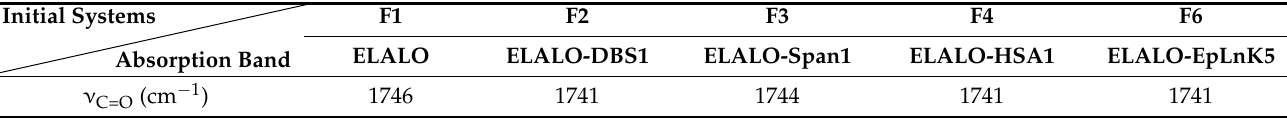
Table 2. Chemical shifts of C=O stretching band for ELALO-based formulations (un-cured). Initial